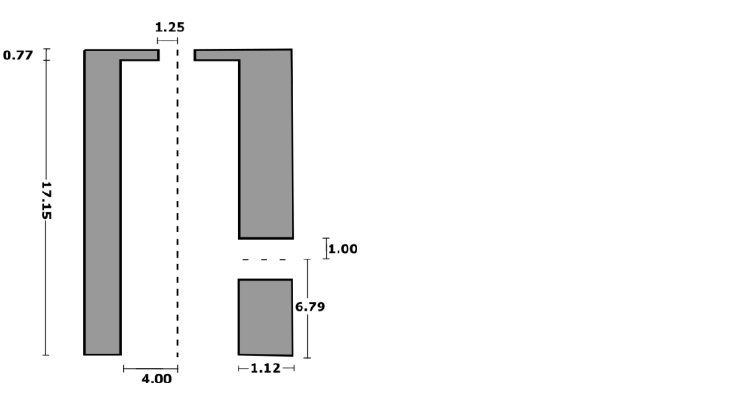
9 of 11 Figure 9. (a): Absolute pressure distribution inside the optimized resonator at 49.2 kHz. (b):